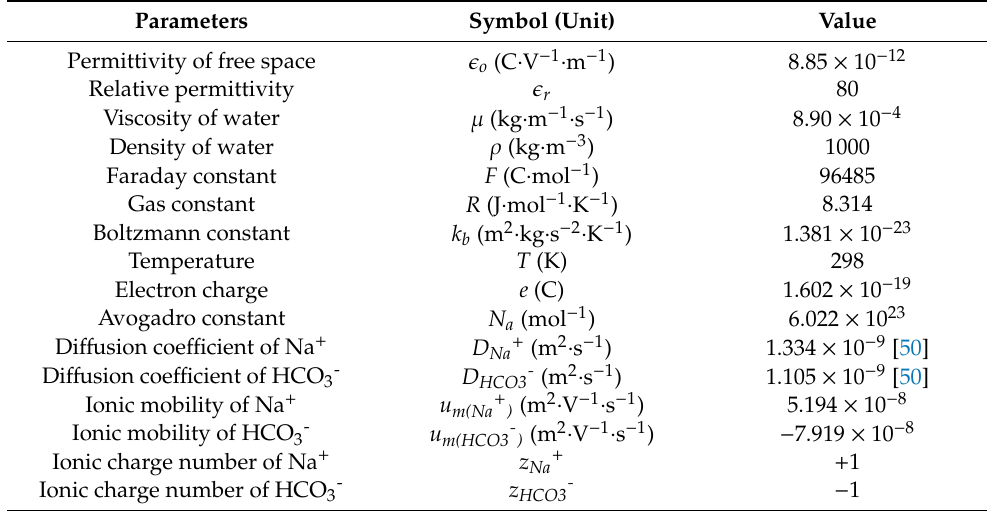
Table 2. Symbols and values of constants for numerical simulations, where ionic mobility of ion species is calculated by formula ( z i D i F ) / ( RT